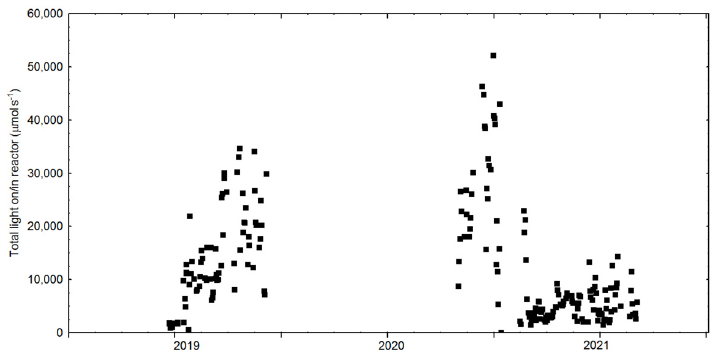
Figure 7. Mean scalar irradiance history in the 300,000 L photobioreactor.